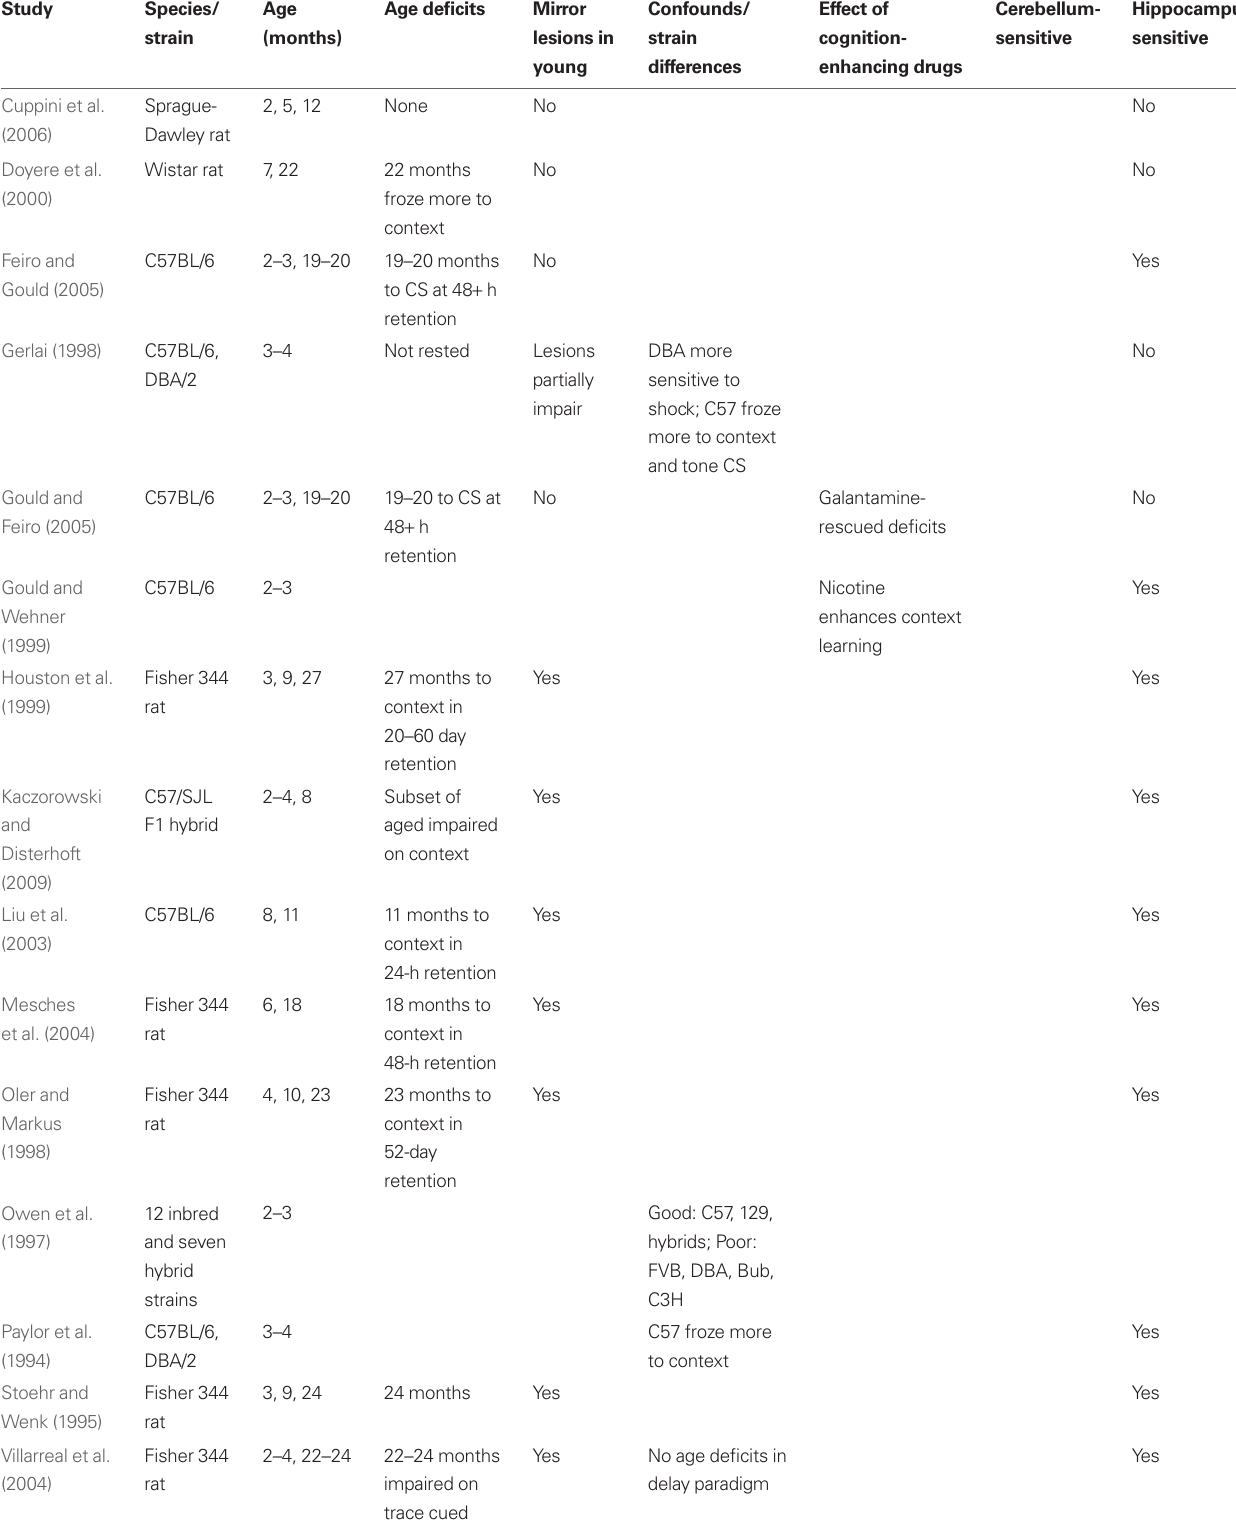
Table 5 | Fear conditioning: age sensitivity.